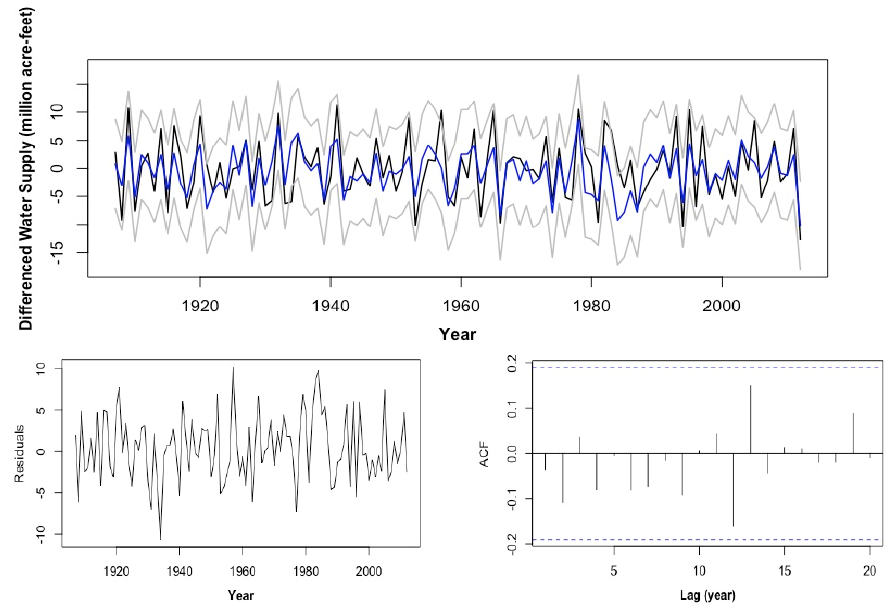
Figure 7. Diagnosis plots of the SARX (19,1,0) model: (top) overlaid plot of the observed annual water supply anomaly (cid:1850) (cid:3047) (black), model fitted value (blue) and its 95% confidence interval (grey); (left) residual plot; (right) ACF of the residual.